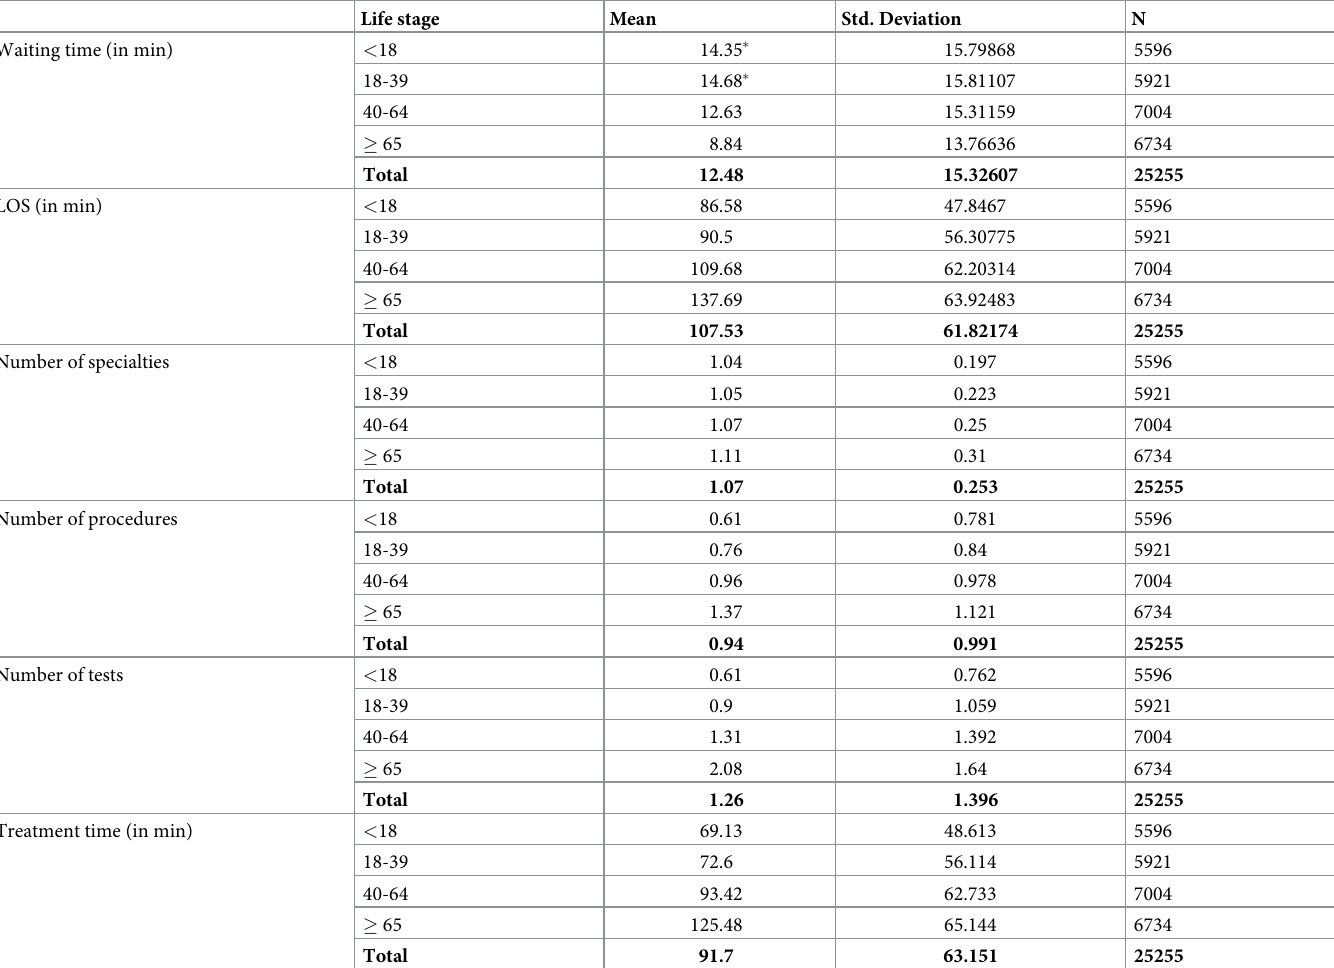
Table 2. Comparison of the mean values of the variables for the different life stages ( < 18, 18-39, 40-64 and � 65). Results are obtained by performing an ANOVA anal- ysis, in which the mean values of each life stage are compared with the mean values of the other life